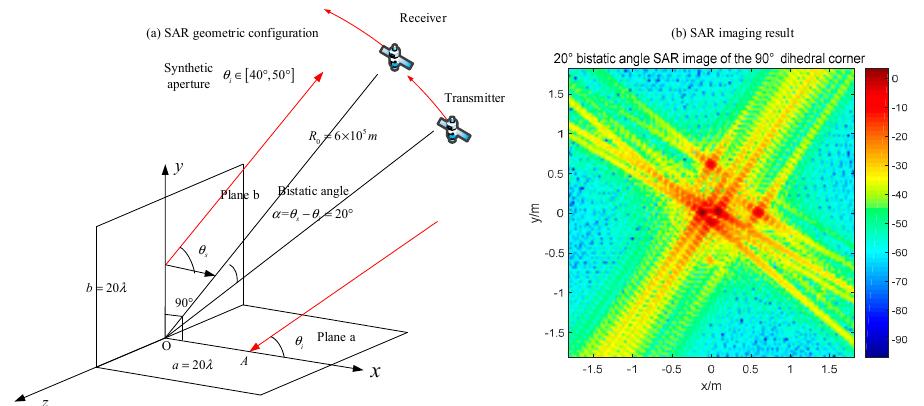
Figure 20. 20° bistatic angle SAR image of the orthogonal dihedral corner ( a ) geometric Figure 20. 20 ◦ bistatic angle SAR image of the orthogonal dihedral corner ( a ) geometric configuration; configuration; ( b ) imaging result. ( b ) imaging result.